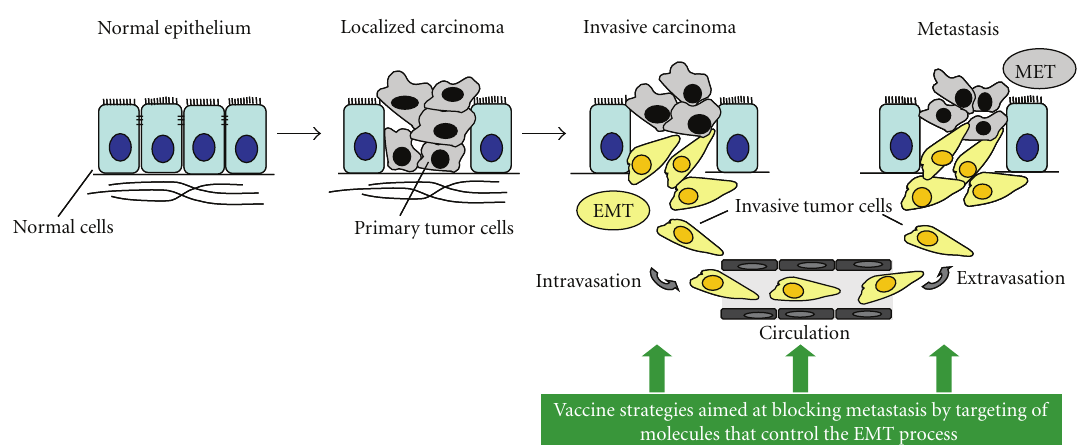
Figure 2: The epithelial-to-mesenchymal transition (EMT) in tumor progression: an opportunity to target metastatic tumor cells. The epithelial-to-mesenchymal transition (EMT) and its reverse process, designated as mesenchymal-to-epithelial transition (MET), are involved in the progression of epithelial tumors towards metastasis. Vaccine strategies targeting molecules that control the EMT process, for example, the transcription factor Brachyury, could be used to block tumor